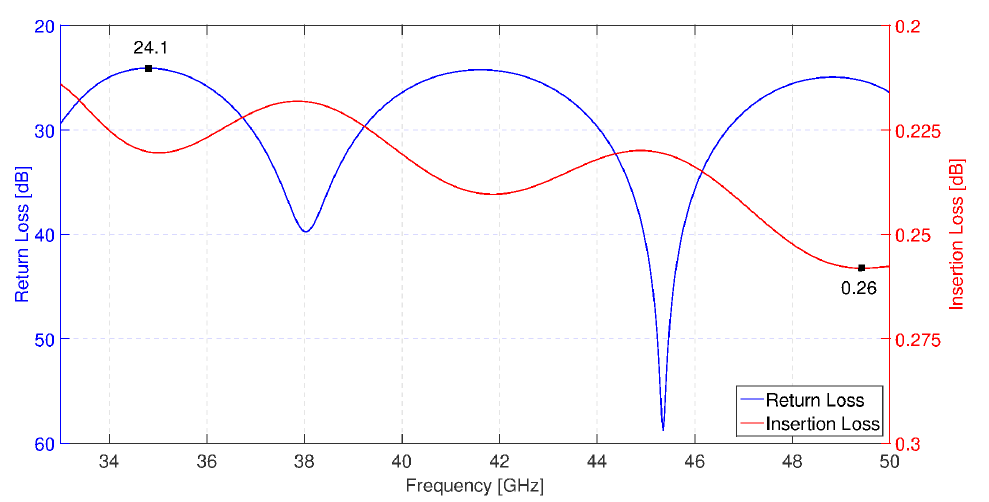
Figure 7. Simulated return loss and insertion loss (Ansys HFSS) of the transition.